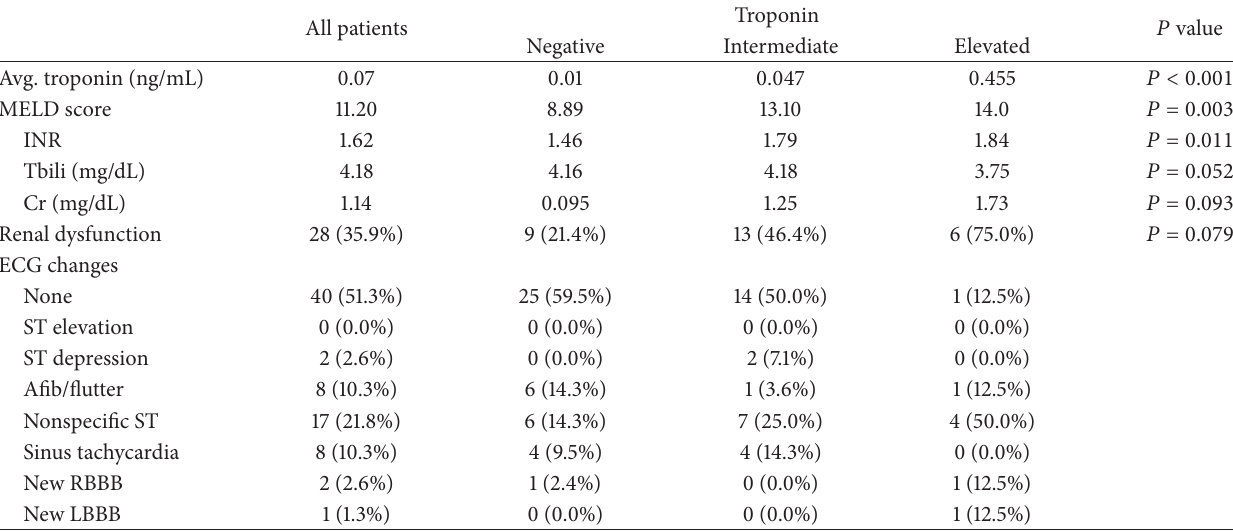
Table 3: Laboratory data and electrocardiogram findings at time of troponin elevation.